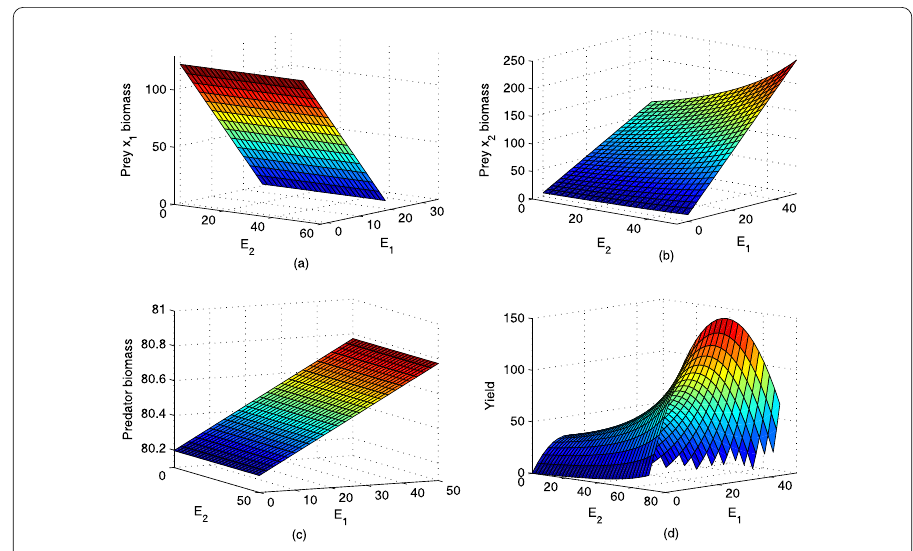
Figure 7 The changes of the biomass of system species and the yield. ( a ) Prey x 1 biomass varies with E 1 and E 2 . ( b ) Prey x 2 biomass varies with E 1 and E 2 . ( c ) The predator biomass varies with E 1 and E 2 . ( d ) The yield from both prey and predator as function of E 1 and E 2 . The relevant parameters except d = 0.4, σ = 0.0035 are given in (7.1) and ( k 1 , k 2 ) = (200,300)